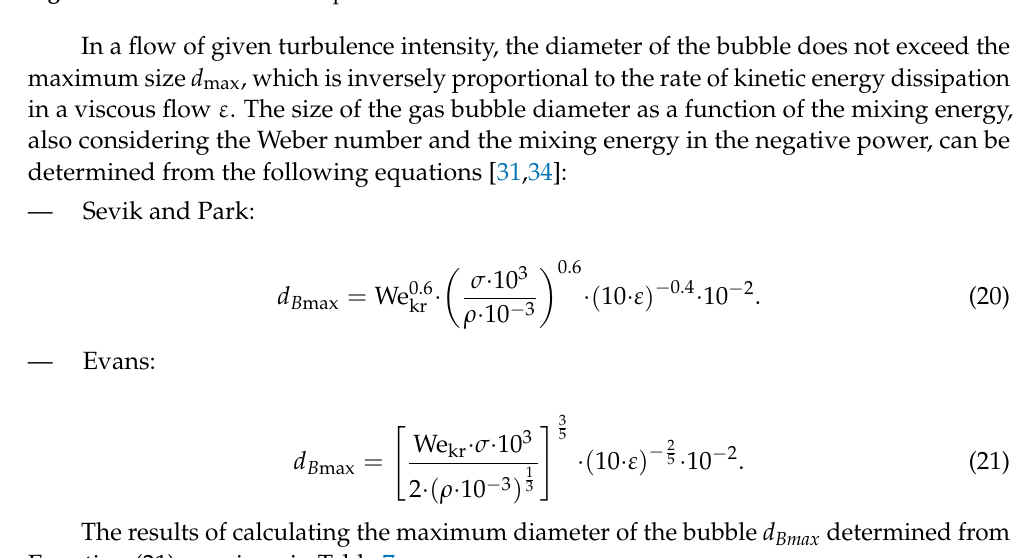
Table 7. The results of calculating the maximum diameter of the bubble using Equation (21).